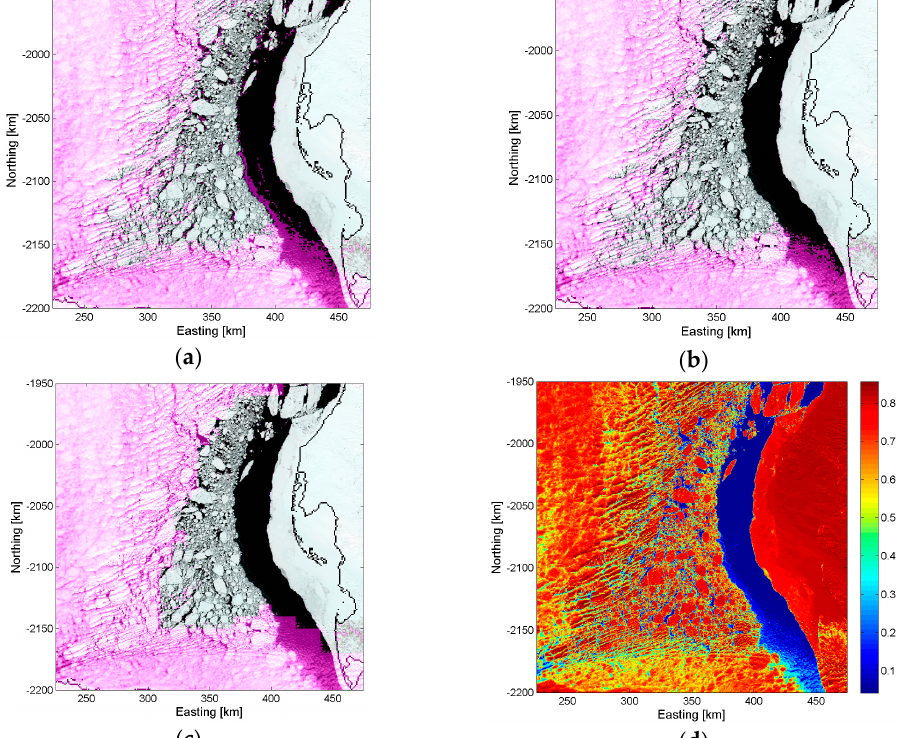
Figure 12. ( a ) MODIS RGB 2-1-1 image with overlaid cloud mask from the MOD35 product (‘cloudy’ of unobstructed FOV confidence flag); ( b ) cloud mask after clear-sky restoration over open water using the band 1 TOA reflectance—amount of false cloud detections over the lead has decreased; ( c ) the final cloud mask in 10 km block size—blocks with less than 25% cloud fraction have cloudy 250 m pixels; and, ( d ) band 1 reflectance image which by visual analysis suggests that there is thin ice in the left edge of the lead, not clouds (see ( a )). The MODIS data was acquired on 12 May 2016 at 07:55 UTC. Coastline is shown in the RGB-images.